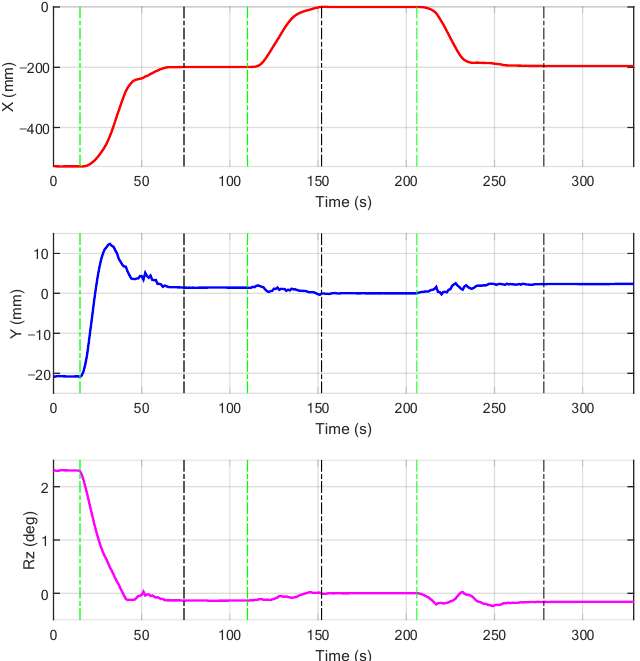
Figure 14. The visual errors of the VS control in the ground MMMS